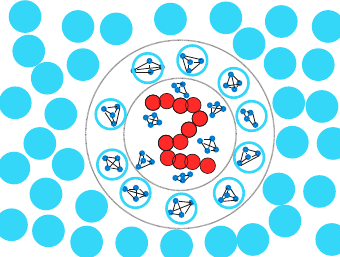
Figure 16. A schematic representation of a generic polymer solution. The structural resolution of the solvent molecules adaptively change based on their distance from the center of the mass of the polymer chain. The polymer beads are represented smaller than the solvent molecules to preserve clarity. Reprinted from Praprotnik et al. [500] with the permission of AIP Publishing. The Adaptive Resolution Scheme (AdResS) was developed by Kremer and co-workers [500,502–507] to simulate systems in which an AA and a CG model are incorporated to model different subregions of the simulation domain at the same time. The atoms and molecules are allowed to diffuse freely from one region to the other using a smooth transition region which links the subregions. AdResS is principally based on the assumption that Newton’s third law should be satisfied the entire simulation box. Additionally, the method assumes that a molecule in the CG